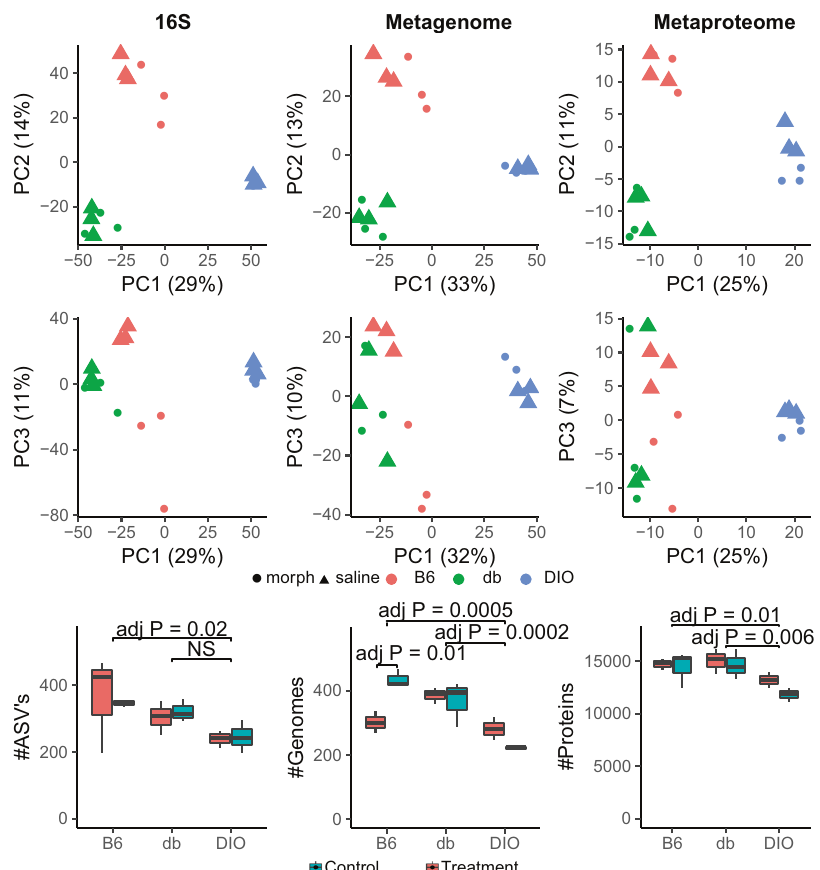
Fig. 2 Diet-induced obesity caused the greatest variation in microbiome composition, while morphine effects were evident only within the B6 line. PCA analysis of normalized abundance of the 16 S ASVs and non-redundant metagenome assembled genomes. Metagenome abundances were calculated by inner-quantile mean coverage and summed spectral counts of unambiguously assigned proteins. Box plots depict number of ASVs, non-redundant genomes, and proteins quanti fi able in each sample. P values were calculated by Tukey HSD after two- way ANOVA comparing both line and treatment, only a single signi fi cant digit